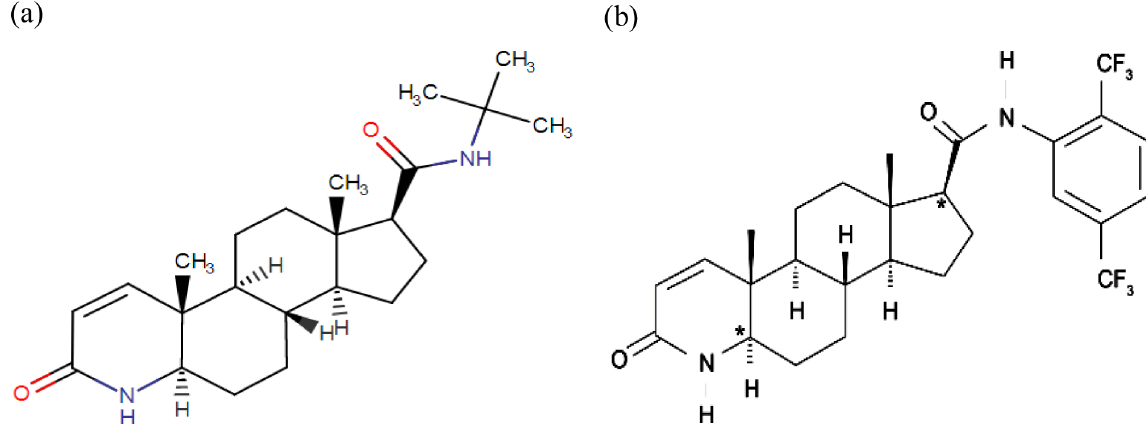
Figure 2. The chemical structure of 5αRis; ( a ) Finasteride, and ( b ) Dustasteride. The figure is adapted and modified from National Center for Biotechnology Information